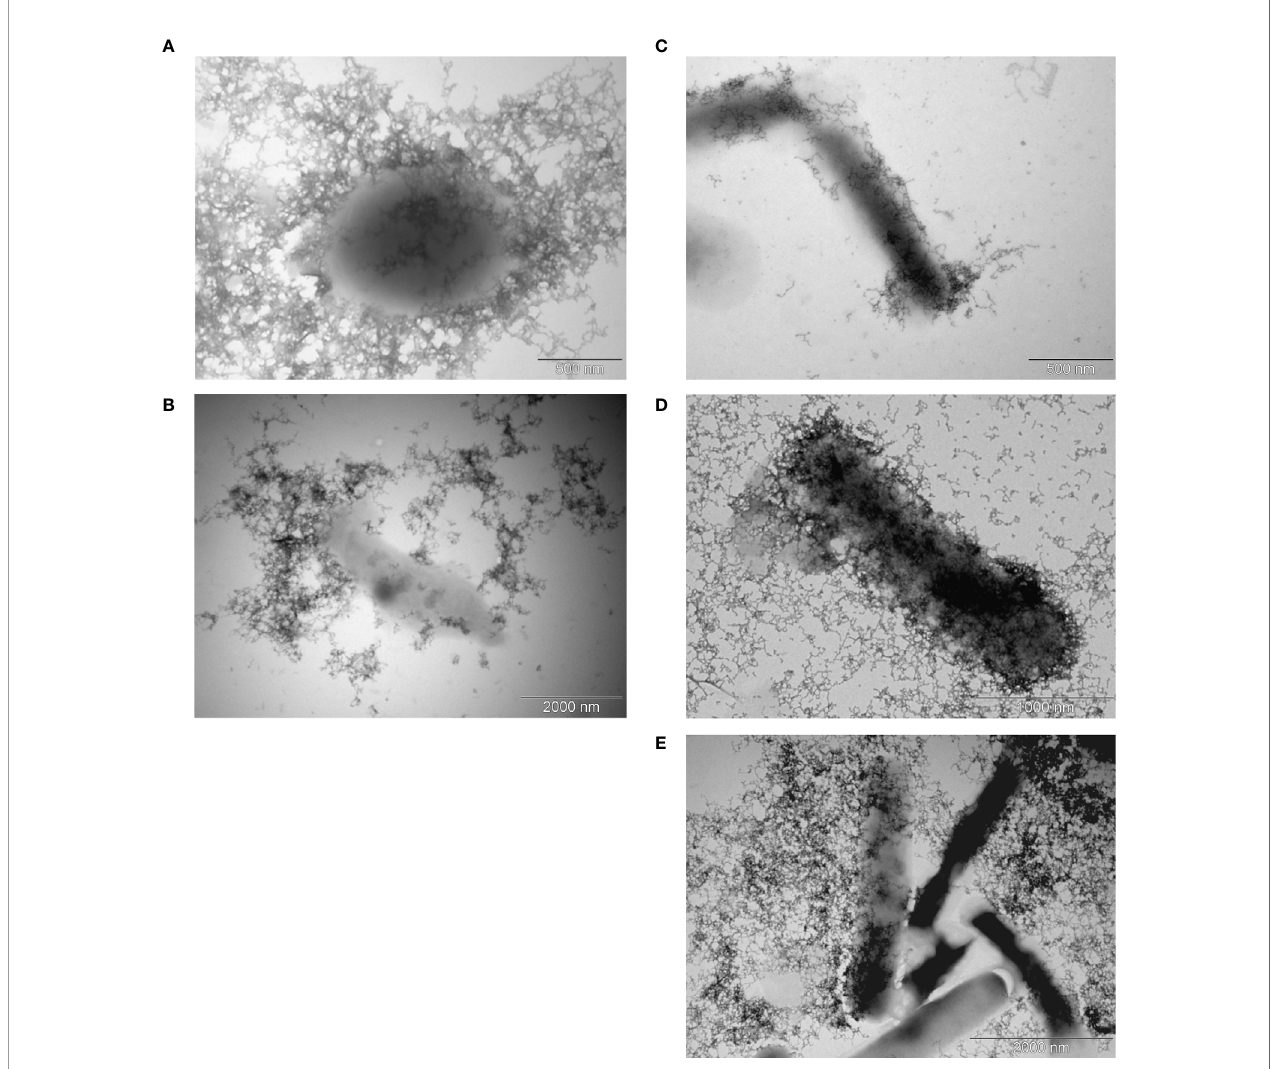
FIGURE 1 | Transmission electron microscopy of the capsule. Encapsulated G. parasuis avirulent strains (A, B) and virulent strains (C – E) are following: strain 131 of serovar 6 (A) , strain D74 of serovar 9 (B) , strain No.4 of serovar 1 (C) , strain CAPM 6475 of serovar 5 (D) , and strain H425 of s. 12 (E)